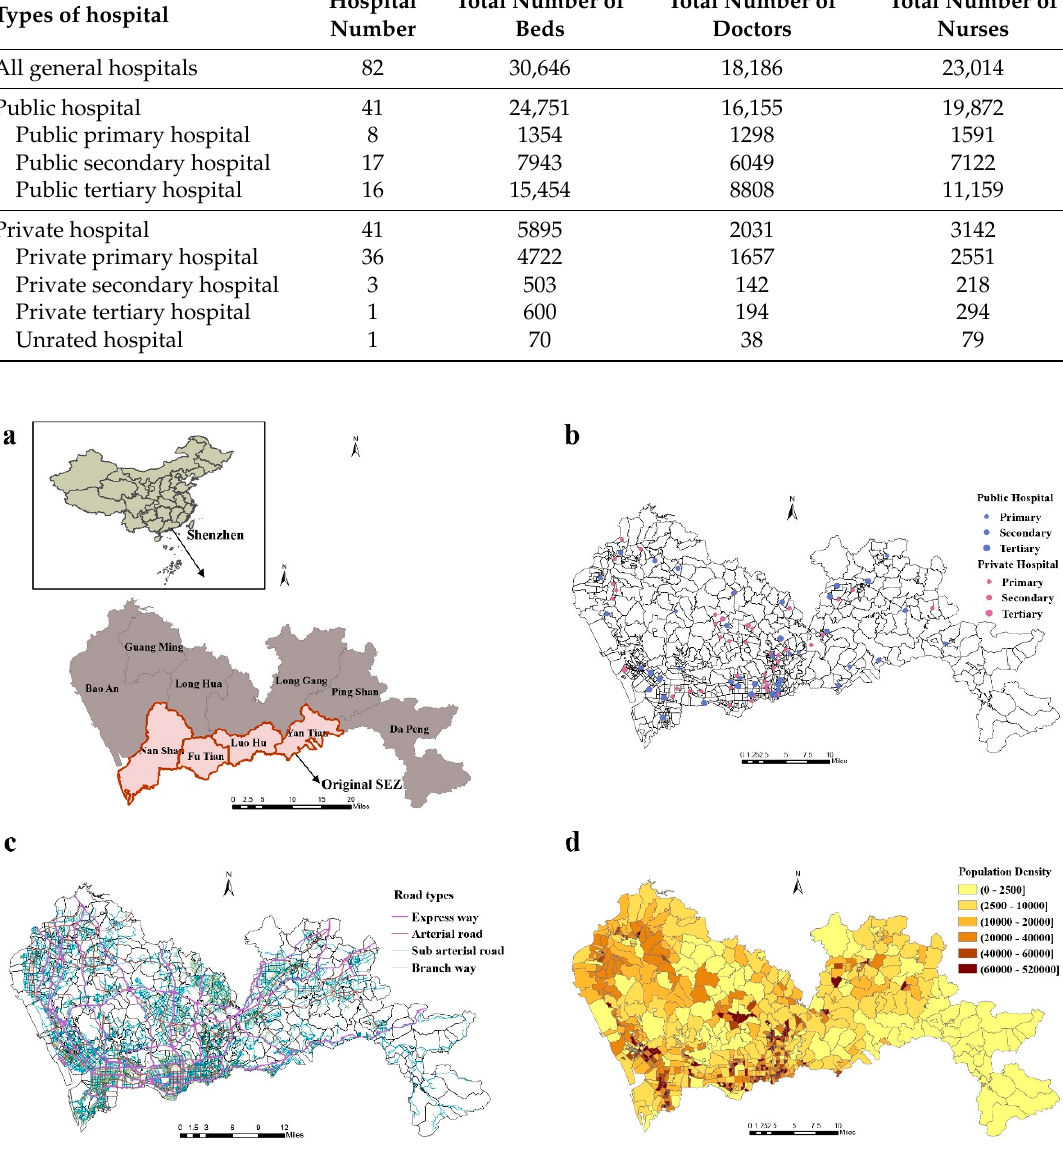
Table 1. Summary of general hospitals in Shenzhen, 2016.